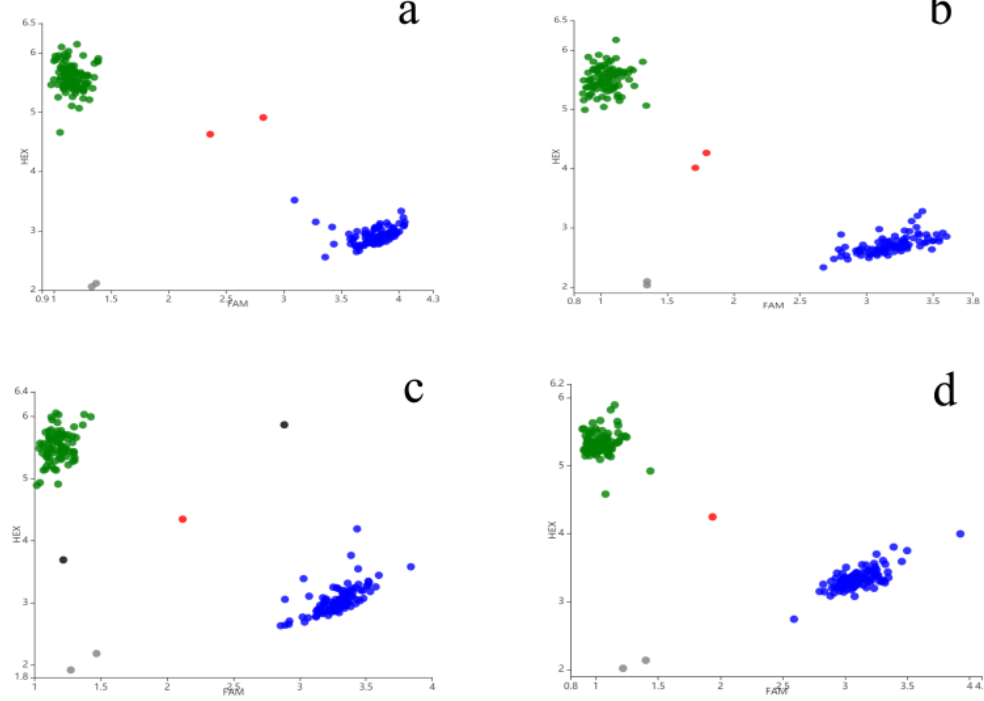
Figure 3. Profiles of four PARMS markers for mapped FHB resistance loci. ( a ) PARMS-AX-111561744 , QFhb.hbaas-2DS , green dots: Susceptible, and blue dots: Resistant; ( b ) PARMS-AX-110591324 , QFhb.hbaas-3AL , green dots: Susceptible, and blue dots: Resistant; ( c ) PARMS-AX-89398511 , QFhb.hbaas-4DS, green dots: Resistant, and blue dots: Susceptible; and ( d ) PARMS-AX-109381281 , QFhb.hbaas-5DL , green dots: Resistant, and blue dots: Susceptible.